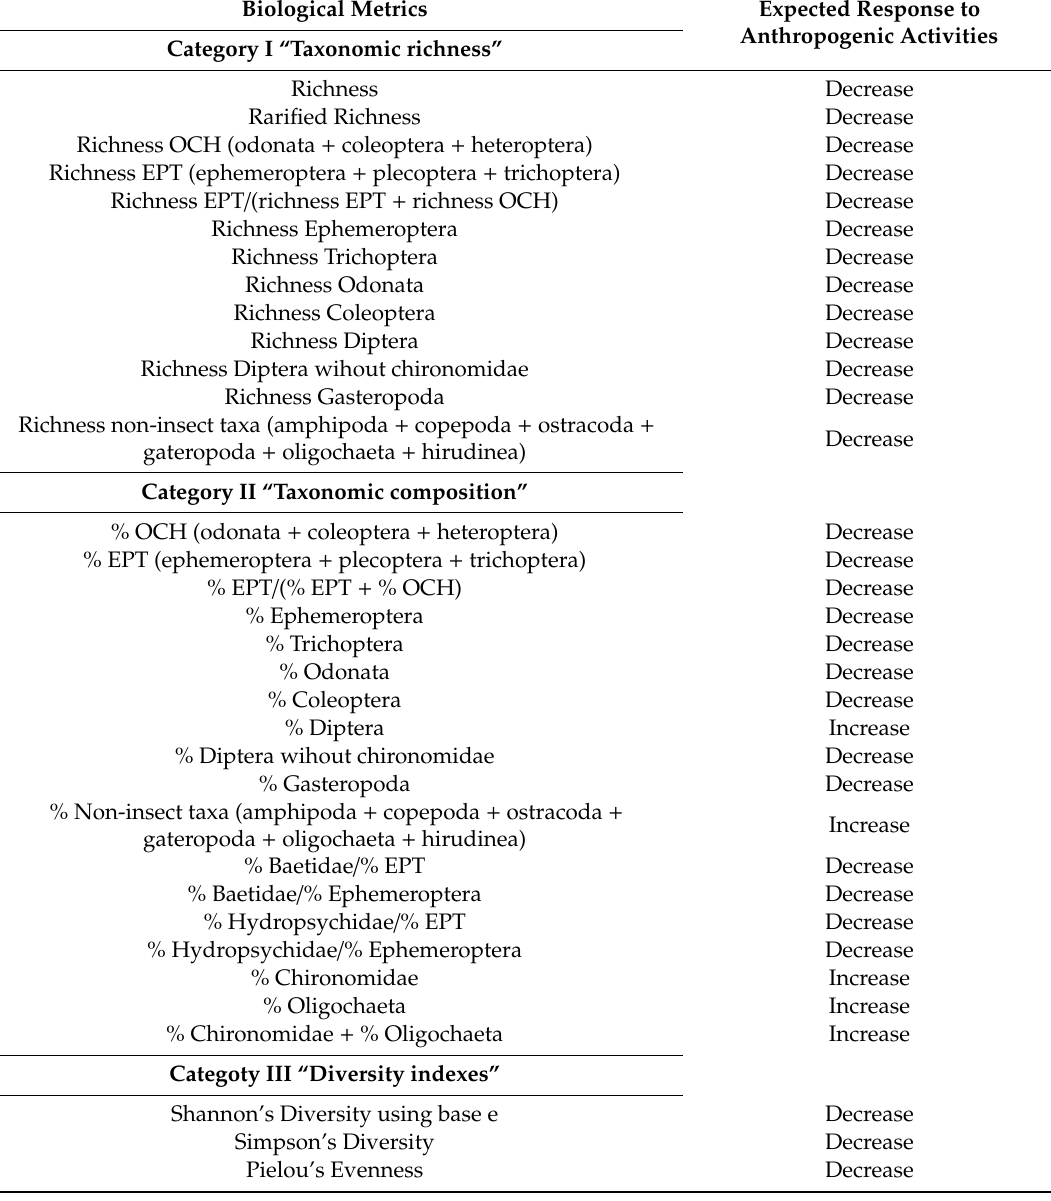
Table 1. Biological metrics categories and their expected response to anthropogenic pressures